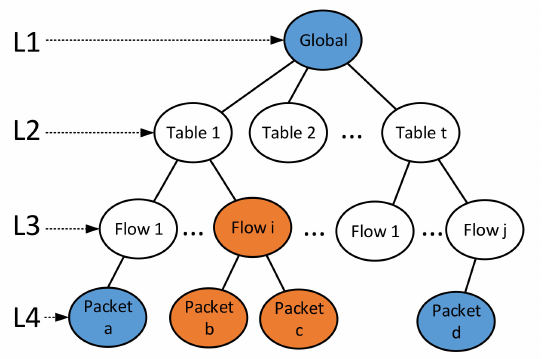
Figure 5. MSSA satisfies any kind of state sharing. At time t , the state shared by packets a and d is recorded in the global state area, and the state shared by packets b and c is recorded in the Table 1 entry i ’s flow state